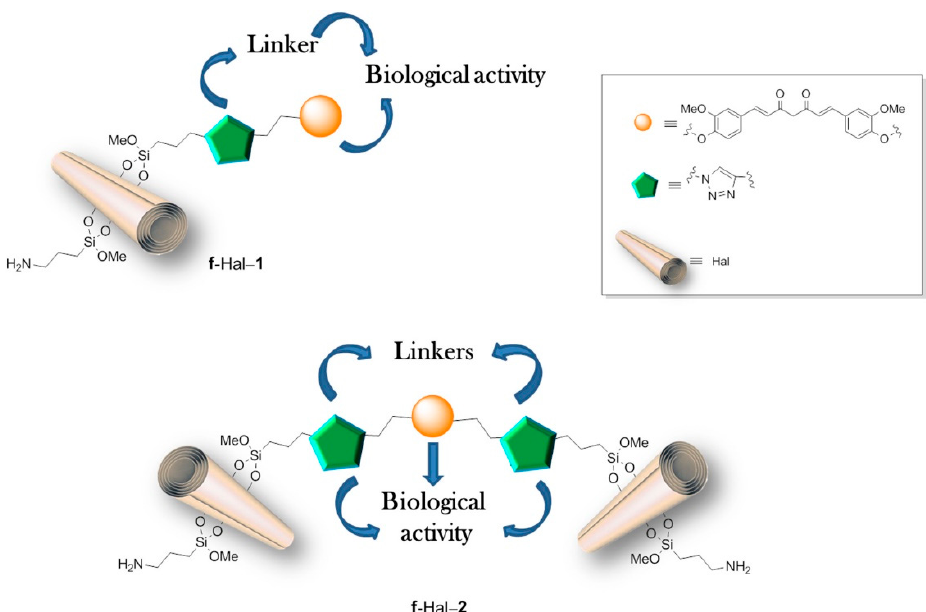
Figure 1. Cartoon representation of the synthetized f-Hal-1 and -2 carrier systems. Reprinted from Applied Clay Science , Vol 184, Marina Massaro, Paola Pomaa, Carmelo G. Colletti, Anna Barattucci, Paola M. Bonaccorsi, Giuseppe Lazzara, Giuseppe Nicotra, Filippo Parisic, Tania M.G. Salerno, Corrado Spinella, Serena Riela, Chemical and biological evaluation of crosslinked halloysite-curcumin derivatives, 105400 (Pages 1–10), Copyright (2020), with permission from Elsevier. [48].